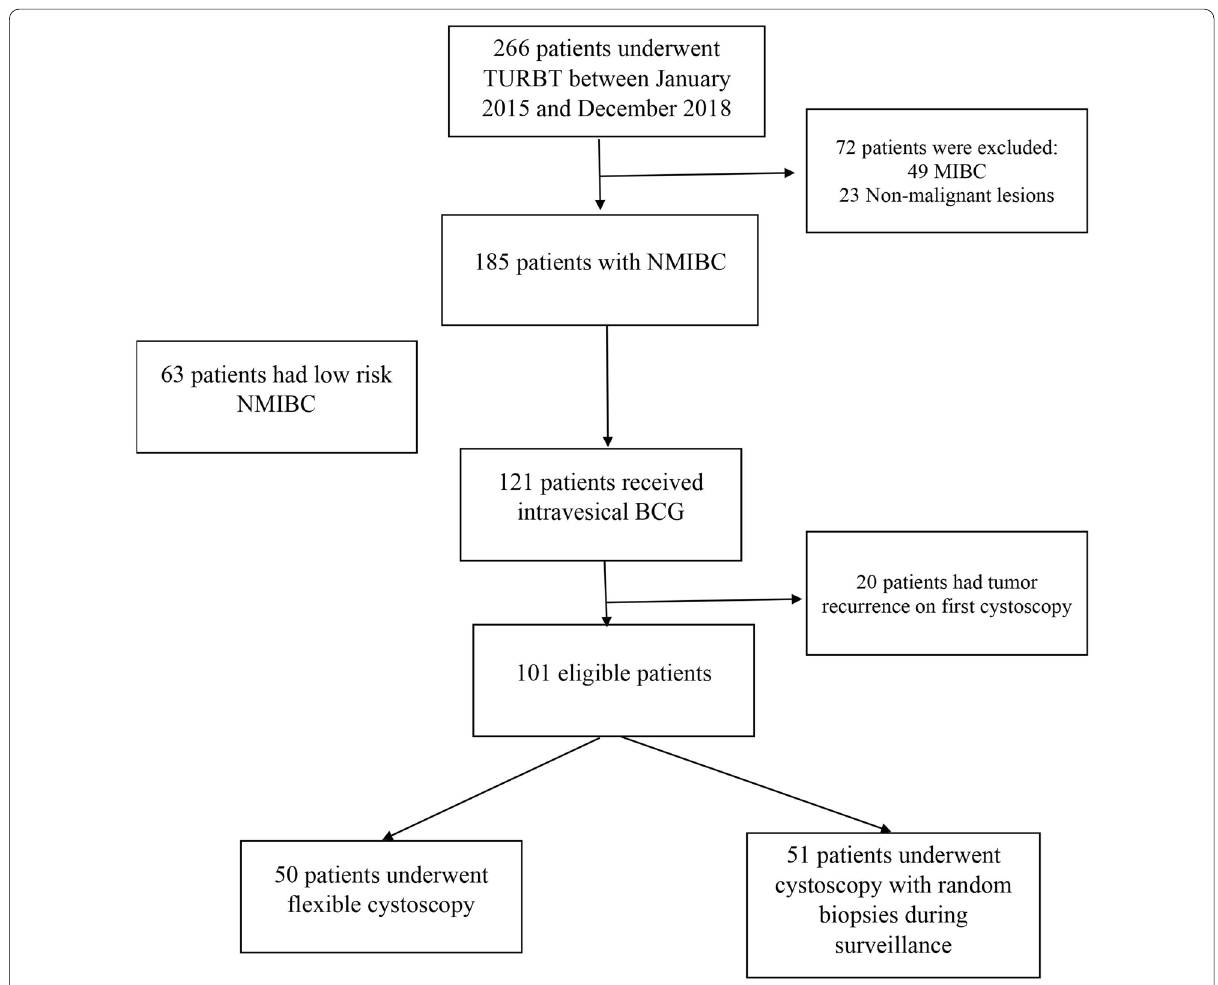
Fig. 1 Flow diagram of study